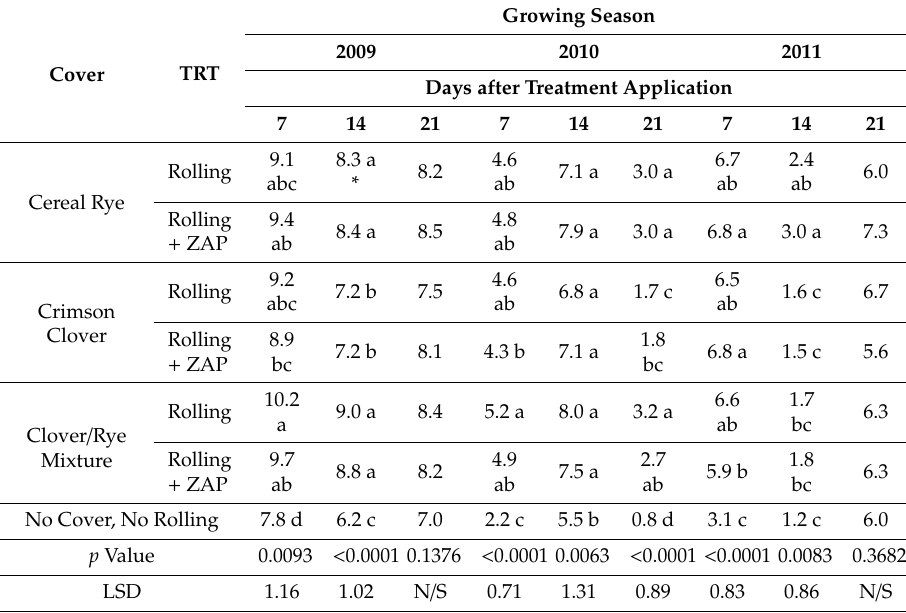
Table 6. Volumetric soil moisture content during 2009, 2010, and 2011 growing